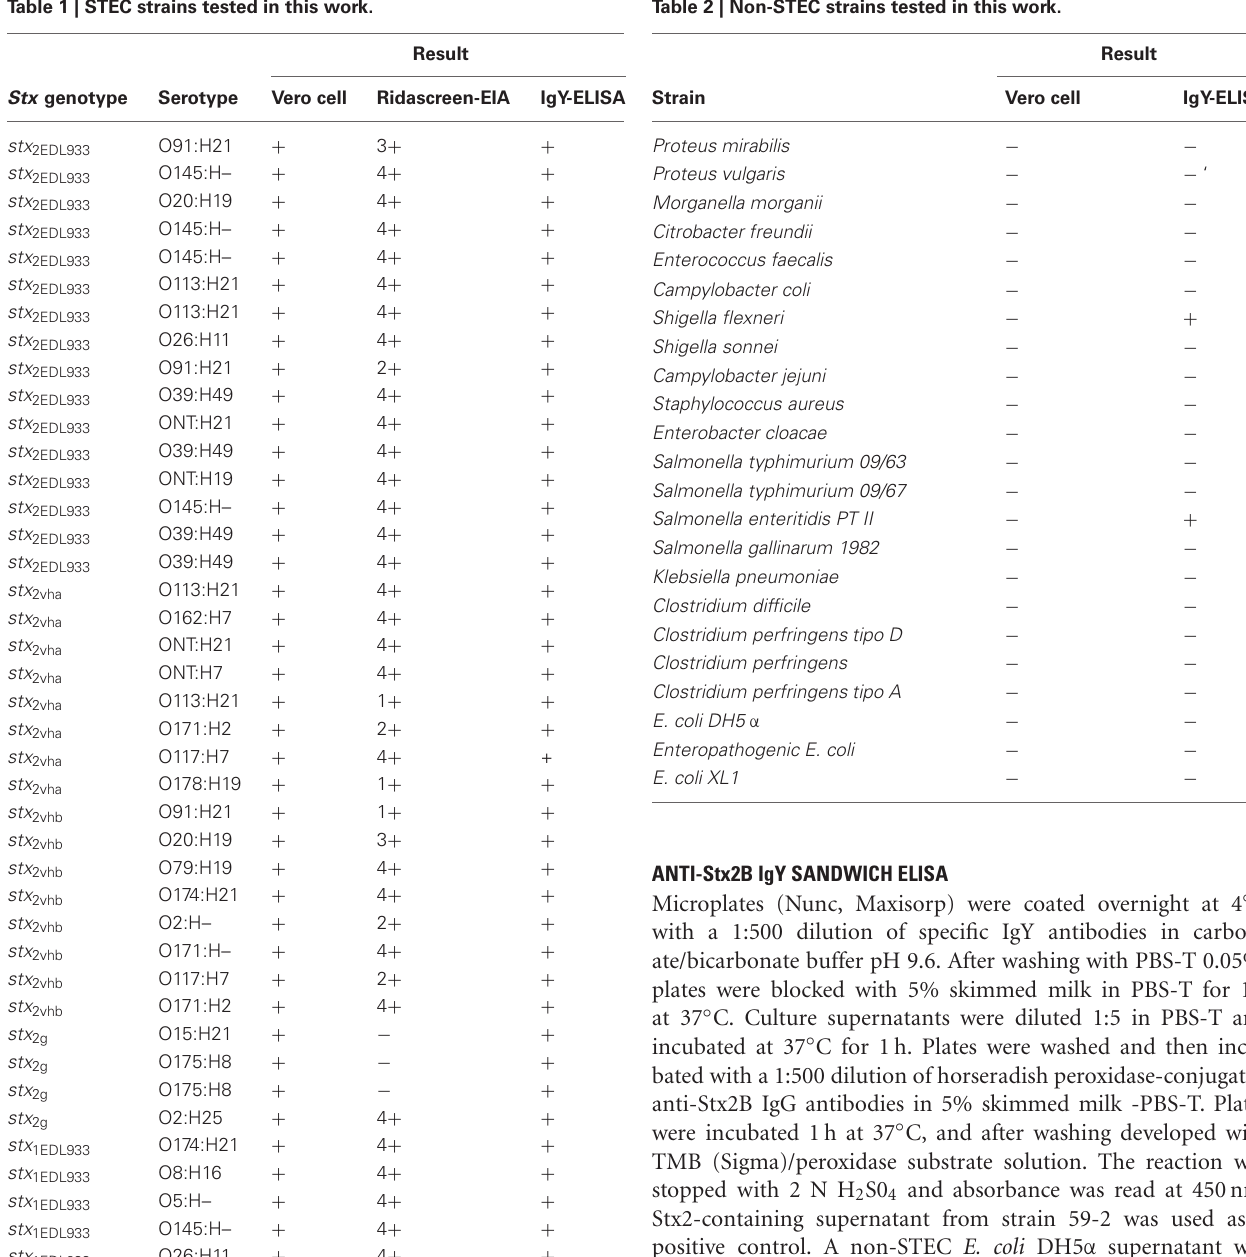
Table 1 | STEC strains tested in this work. Table 2 | Non-STEC strains tested in this